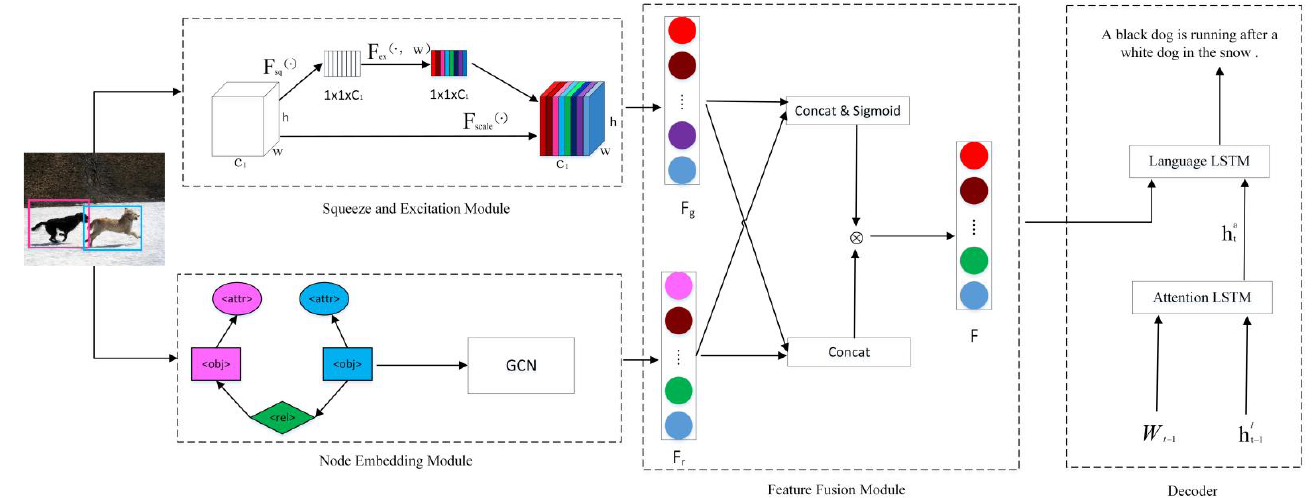
Figure 1. The network architecture of the fusion − feature model.